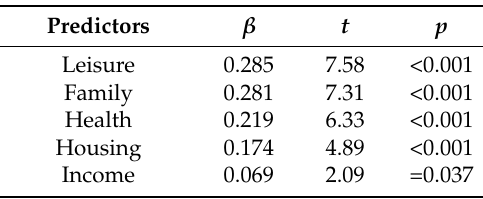
Table 9. Standardized regression coefficient ( β ), t -value, and p -value for predictors of overall satisfaction score for Survey 3. Personality measured with